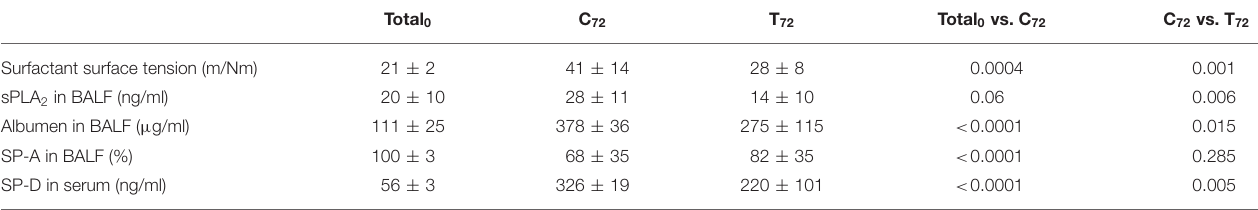
TABLE 8 | Surfactant surface tension and alveolar-capillary leakage.